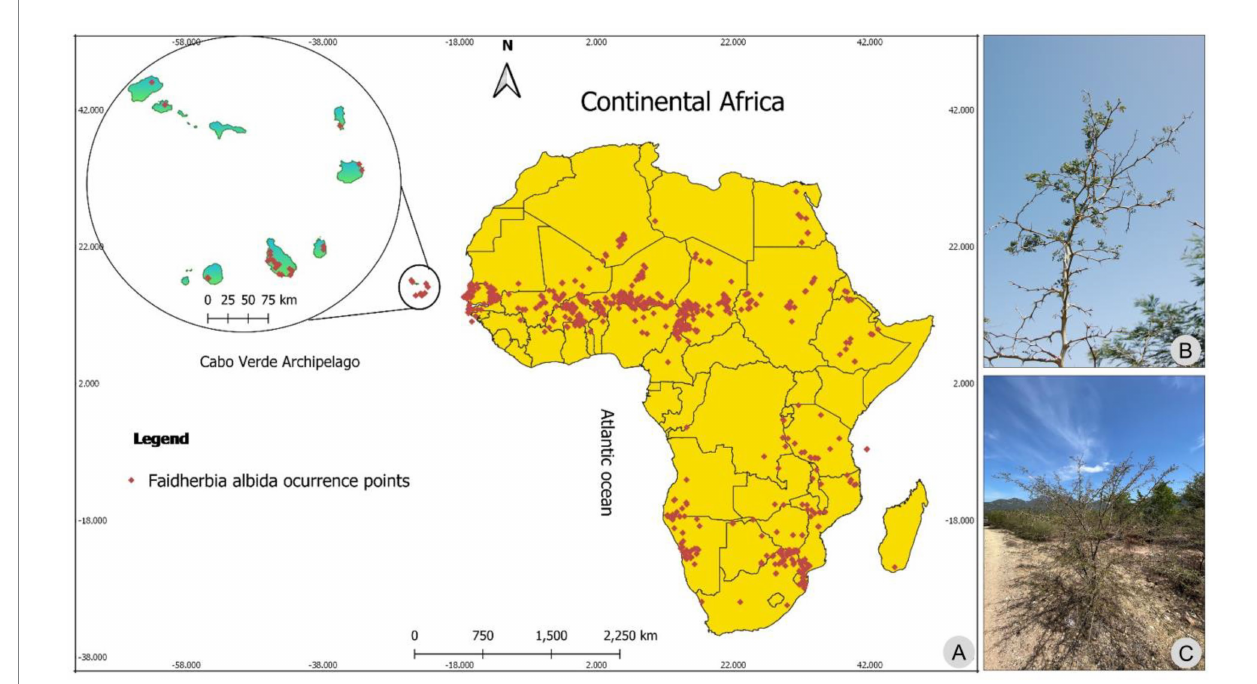
FIGURE 1 Occurrence points of Faidherbia albida in Africa mainland and Cabo Verde islands (A) . Details of Faidherbia albida (B) and African woodlands (C) . Photos by M.M.